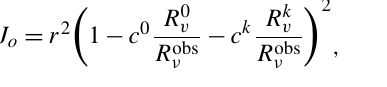
c k (on the x axis) on specified model levels k (on the y axis) from 10 to 100 % every 10 %. With a fraction c k of one- layer cloud at a given level k and a fraction of c 0 = 1 − c